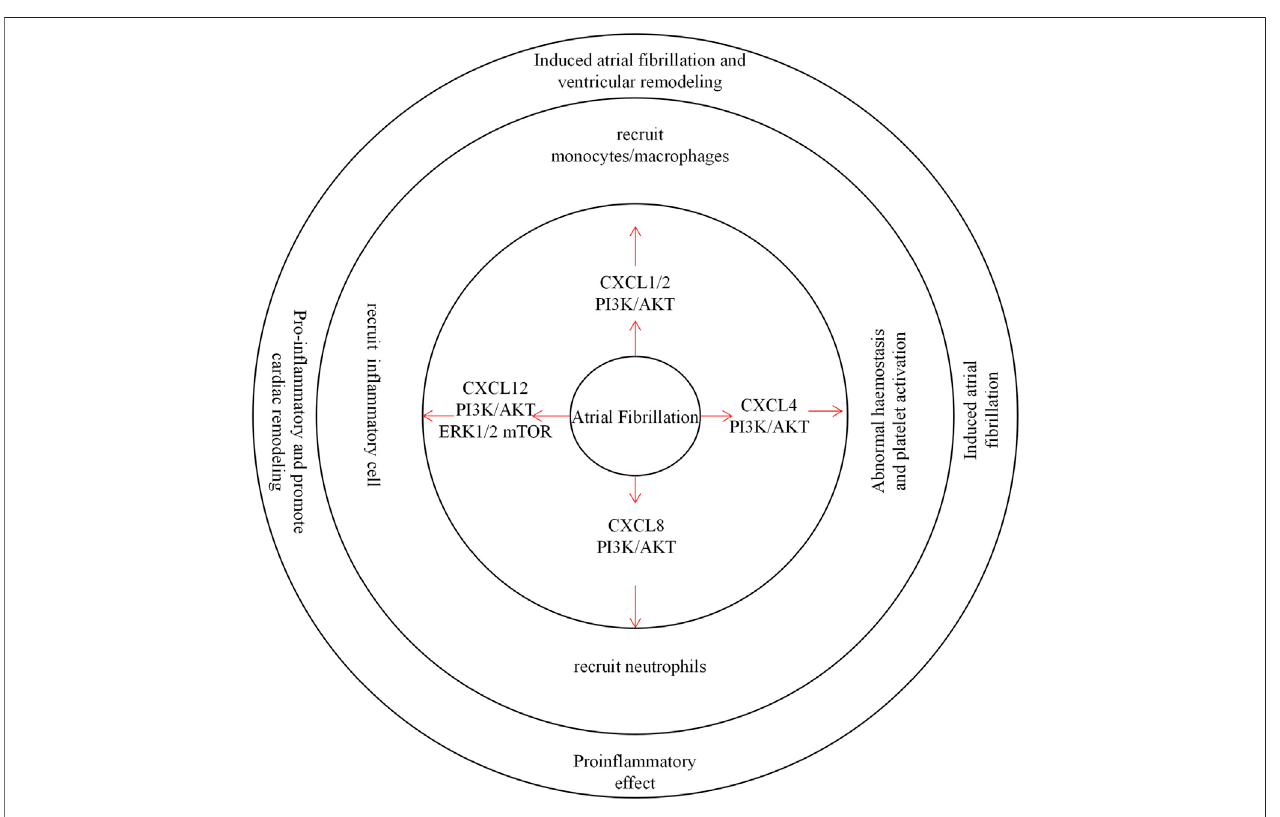
FIGURE 4 | CXC chemokines in Atrial Fibrillation. CXCL1/2 recruits monocytes/macrophages through the PI3K / AKT pathway to induce atrial fi brillation and ventricularremodeling.CXCL4isinvolvedinhemostasisandabnormalplateletactivation,inducingthedevelopmentofatrial fi brillation.CXCL8recruitsin fl ammatorycells throughthePI3K/AKTpathway andplays apro-in fl ammatoryrole.CXCL12 recruitsin fl ammatorycellsand promotes in fl ammation associatedwithcardiacremodeling.